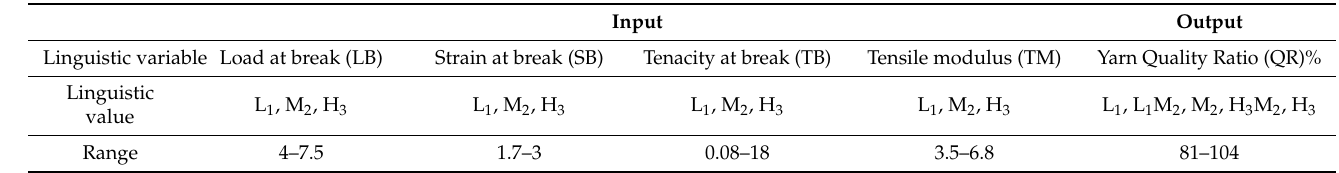
Table 1. Fuzzy Inference System (FIS) properties.